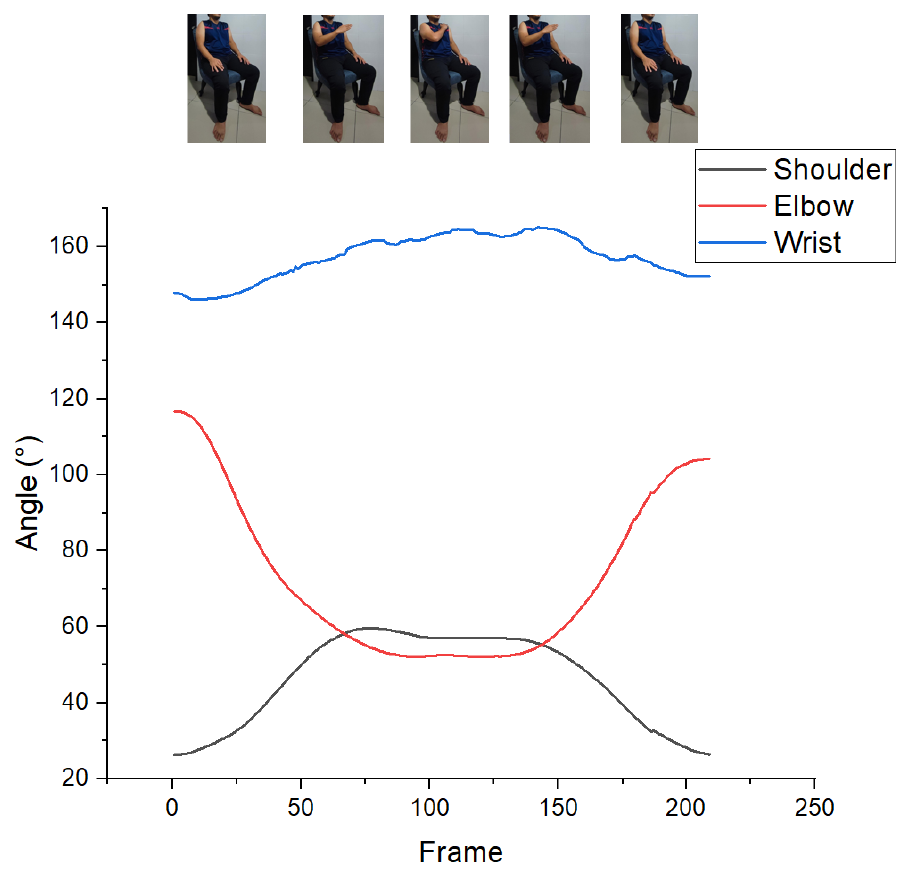
Figure 2. A sample of angles for shoulder, elbow and wrist during touching of contralateral shoulder for a normal subject.